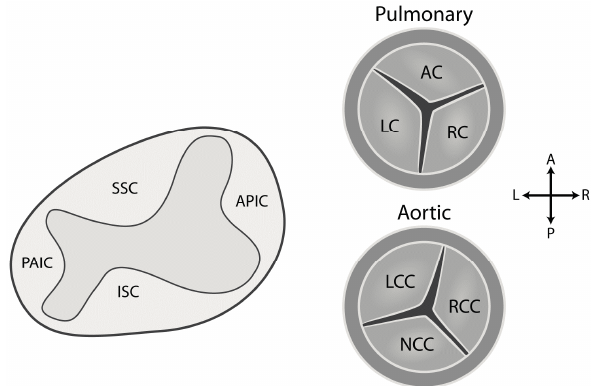
Figure 5. Development of the leaflets of the aortic and pulmonary valves. The semilunar valves arise from the conotruncal and intercalated cushions of the outflow